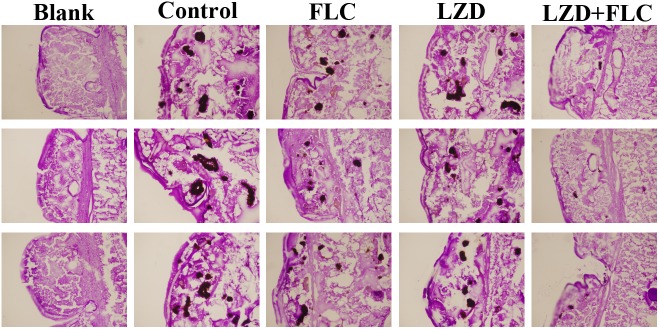
Histopathology of infected G. mellonella larvae treated with different drugs. CA10 (5 × 108 CFU/mL) was used to infect the G. mellonella larvae (20 larvae for each group). After infection, the larvae were treated with sterile PBS, FLC (160 μg/mL), LZD (200 μg/mL), and LZD (200 μg/mL) plus FLC (160 μg/mL), respectively. Two larvae from each group were randomly chosen after 2 days of incubation and cut into 20-μm sections. Sections were stained with PAS reagent and observed under the fluorescence microscope. The larvae of the blank groups were not treated with yeast and drugs. Tissue sections were observed using 4.2 × 10 magnifications, with a scale of 200 μm.